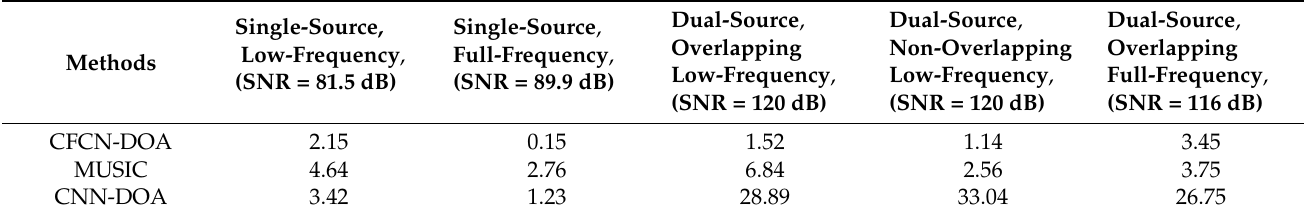
Table 3. Mean OSPAs for the experiment in semi-anechoic chamber (Unit: ◦ ).